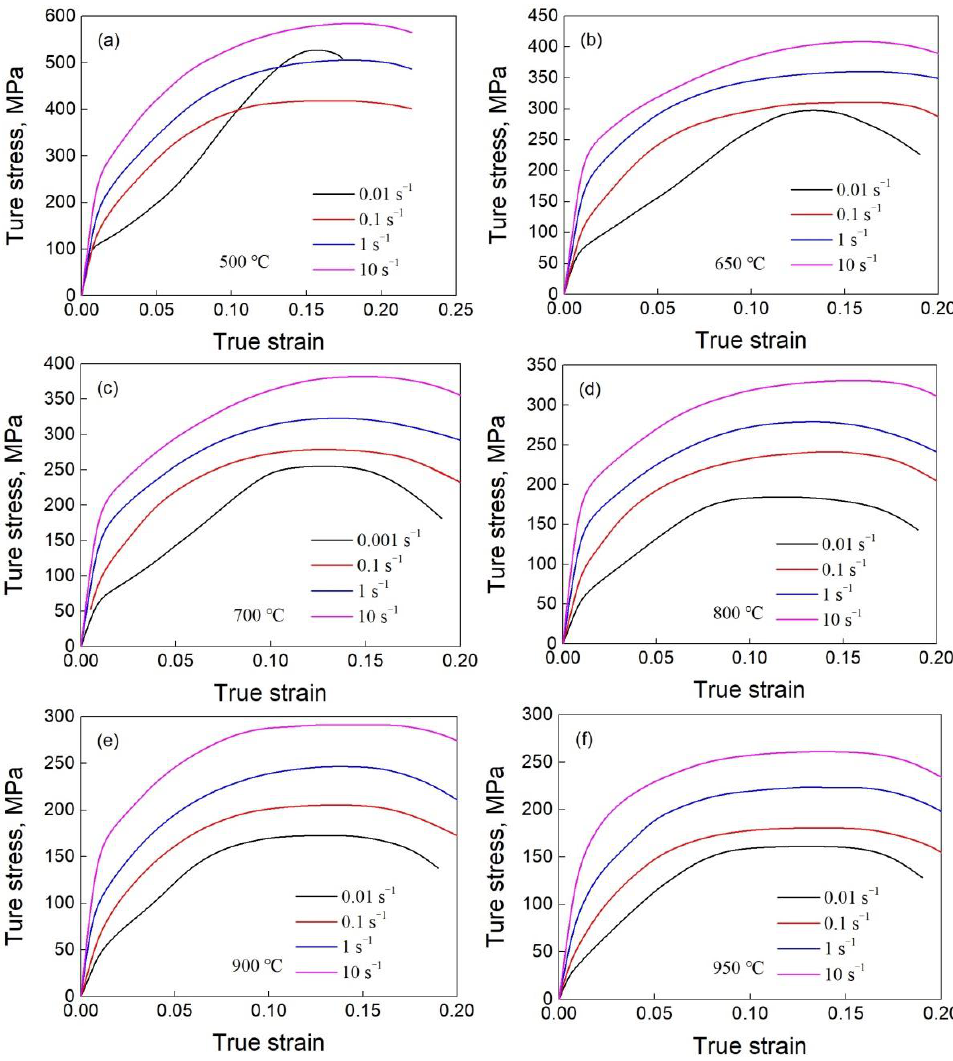
Figure 3. True stress – true strain curves of the studied steel at deformation temperatures of ( a ) 500 °C, ( b ) 650 °C, ( c ) 700 °C, ( d ) 800 °C, ( e ) 900 °C and ( f ) 950 °C.